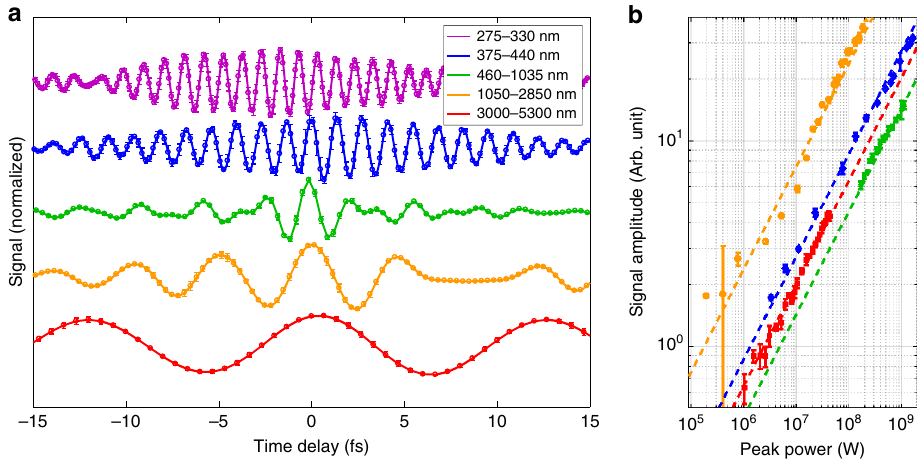
Fig. 5 Broadband electric- fi eld measurement from the infrared to ultraviolet. a Waveforms in different spectral ranges spanning the mid-infrared to ultraviolet are detected by NPS, triggered by a 2.7 fs near-infrared visible pulse. The waveforms covering 3000 – 5300 and 1050 – 2850 nm are generated via difference-frequency generation in LiNbO 3 and BBO, respectively. The waveform covering 460 – 1035 nm is generated by the spectral broadening of a 21 fs, 790 nm pulse from a Ti:sapphire laser in a neon- fi lled hollow-core fi ber and compressed with chirped mirrors to 2.7 fs duration (this waveform drives all other nonlinear processes presented). The waveforms covering the spectral ranges 375 – 440 and 275 – 330 nm are both generated via sum-frequency generation in BBO, using different phase-matching conditions. The error bars represent the standard deviation of repeated measurements. b Using variable attenuation, the driving pulse energies are reduced and the signal is plotted vs. input pulse peak power, exhibiting both the linearity of the fi eld response ffiffiffi p P and its large dynamic range. The dashed lines are fi tted linear fi eld responses (i.e. scaling with , the square root of the peak power). The absolute positions of the lines on the vertical scale result from both the wavelength-dependent sensitivity of the measurement, which favors longer wavelengths, and the spatio-temporal properties of the frequency-converted beams. This causes the driving fi eld strength, which determines the signal strength, to depend on more variables than the power alone, but their proportionality with fi xed beam parameters exhibits the linearity of the